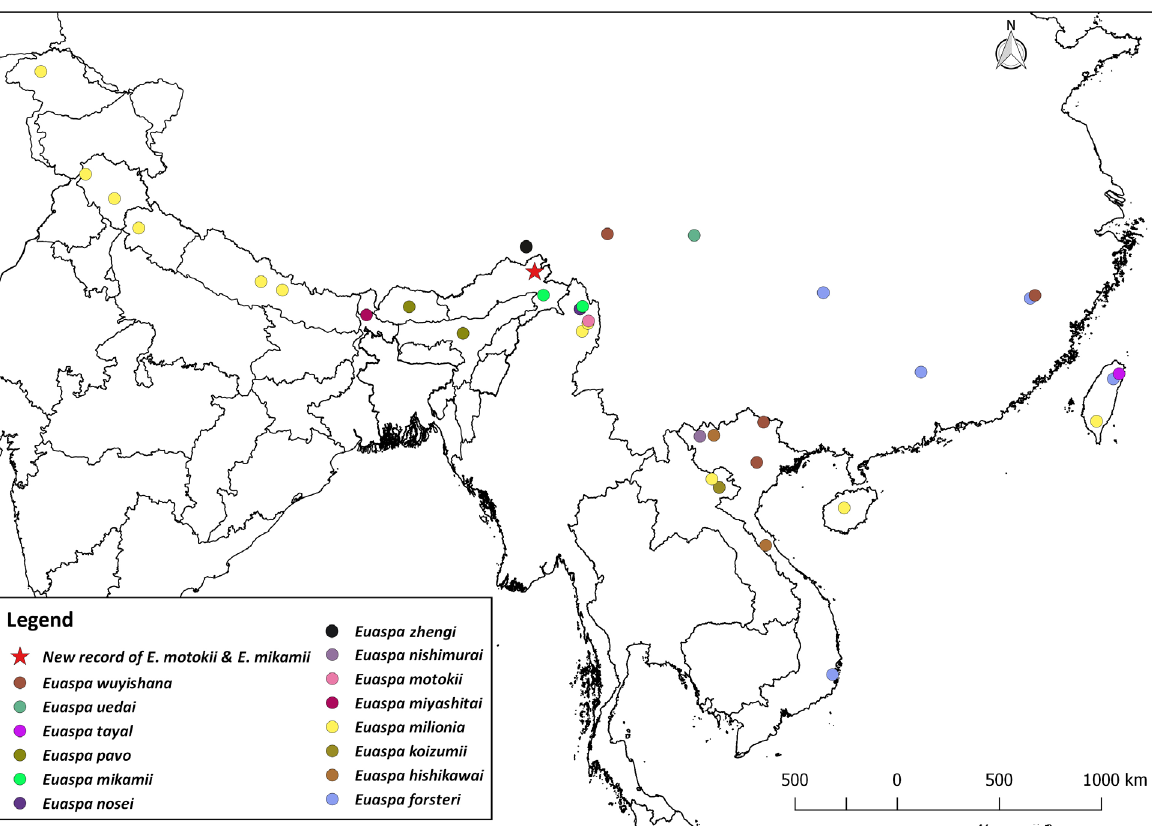
Figure 1. Distribution of 14 species of the genus Euaspa , including current records of E. motokii and E. mikamii from Arunachal Pradesh ( ) (data extracted from Huang 2016 and Zhuang et al.